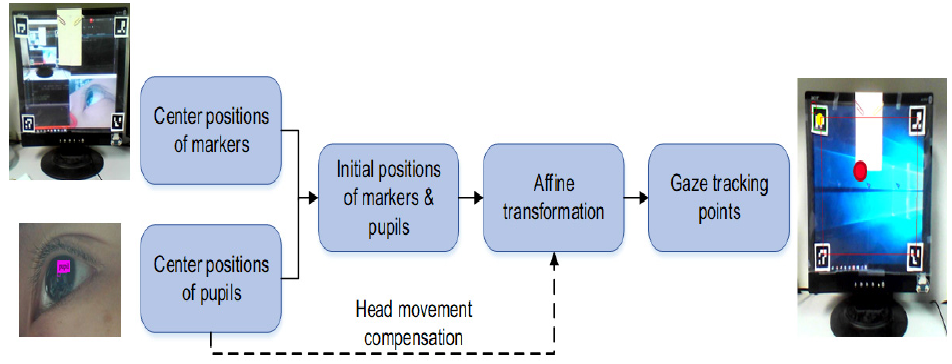
Figure 11. The used calibration process of the proposed wearable gaze